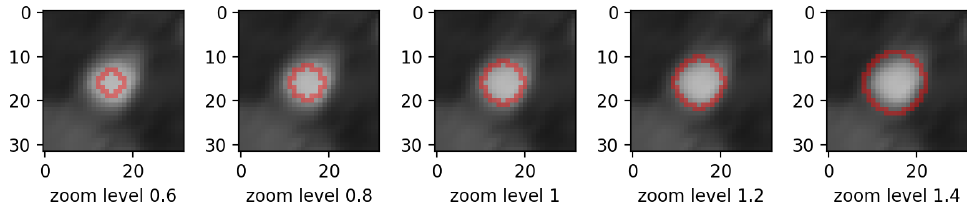
Figure 3. Example of zoom perturbation on lumen mask. Only the mask contour is shown.